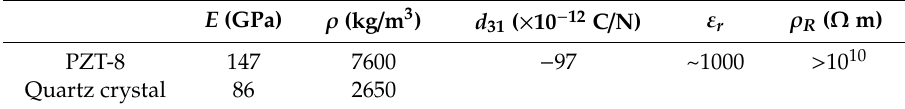
Figure 3. Gate oscillator circuit. Table 2. The typical parameters of PZT-8 and quartz